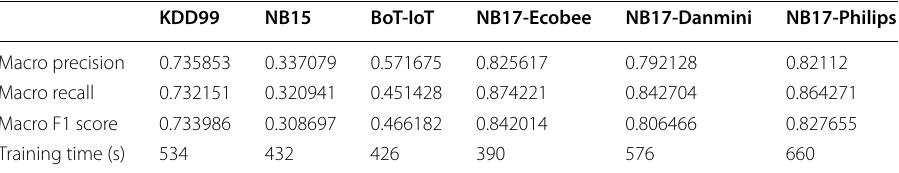
Table 8 ANN Classification results on AWS with Spark (no